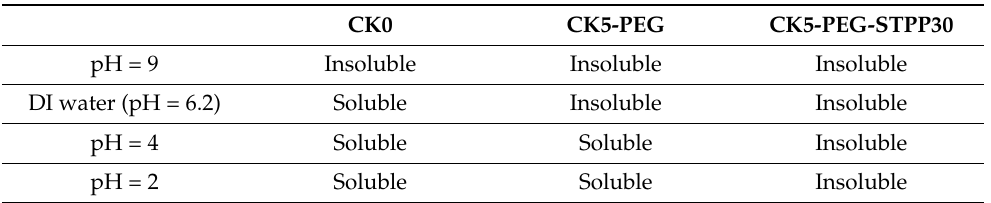
Table 1. Solubility of KO/CS composite membranes compared to that of pristine CS membrane (CK0) in water at different